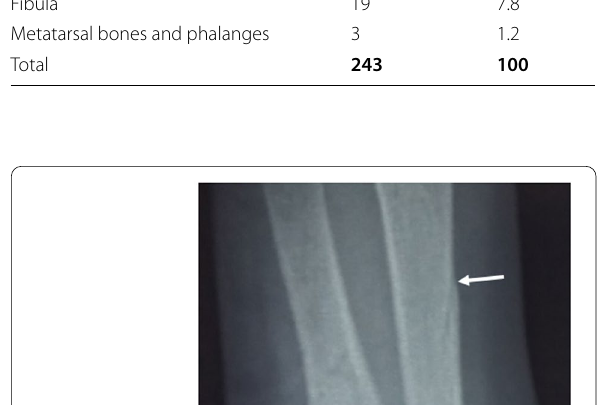
Fig. 3 Buckle fracture. Distal forearm anteroposterior x-ray, showing bowing of both medial and lateral radial cortices (white arrows), with a visible fracture line on the metaphysis (black arrow)